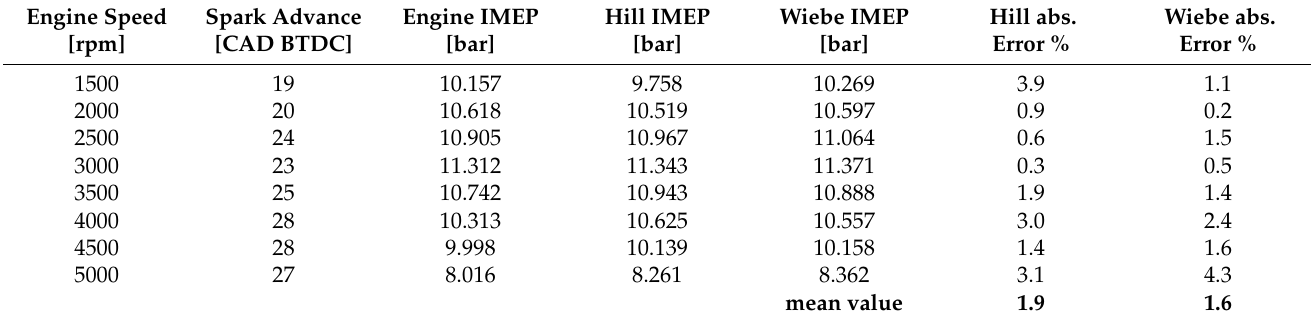
Table 13. Experimental and simulated IMEP with absolute prediction errors (80% NG; MAP = 1.2 bar).